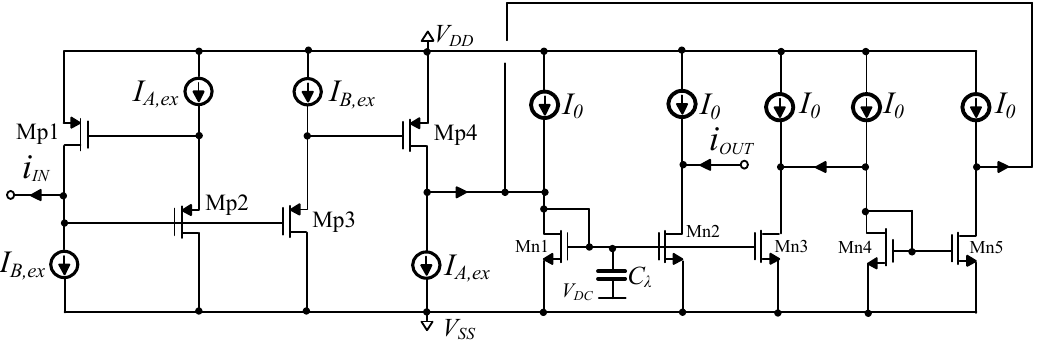
Figure 13. Fractional-order integration topology with an extra gain stage for achieving large time